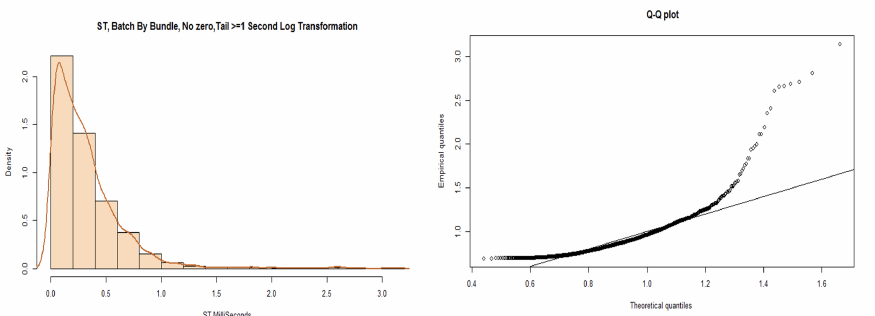
Figure 13. Batch by bundle, ST, tail.